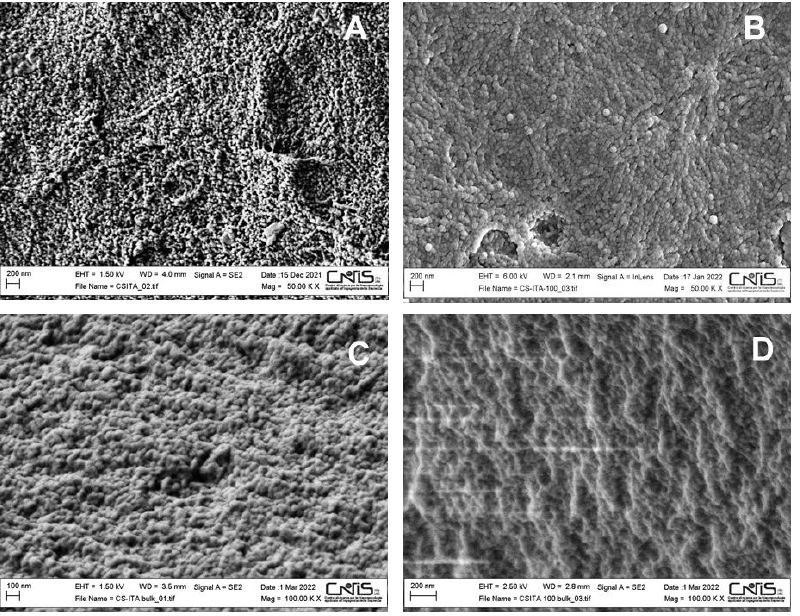
Figure 4. SEM images of the surface ( A ) and bulk ( C ) of CS_ITA, and surface ( B ) and bulk ( D ) of CS_ITA_5.